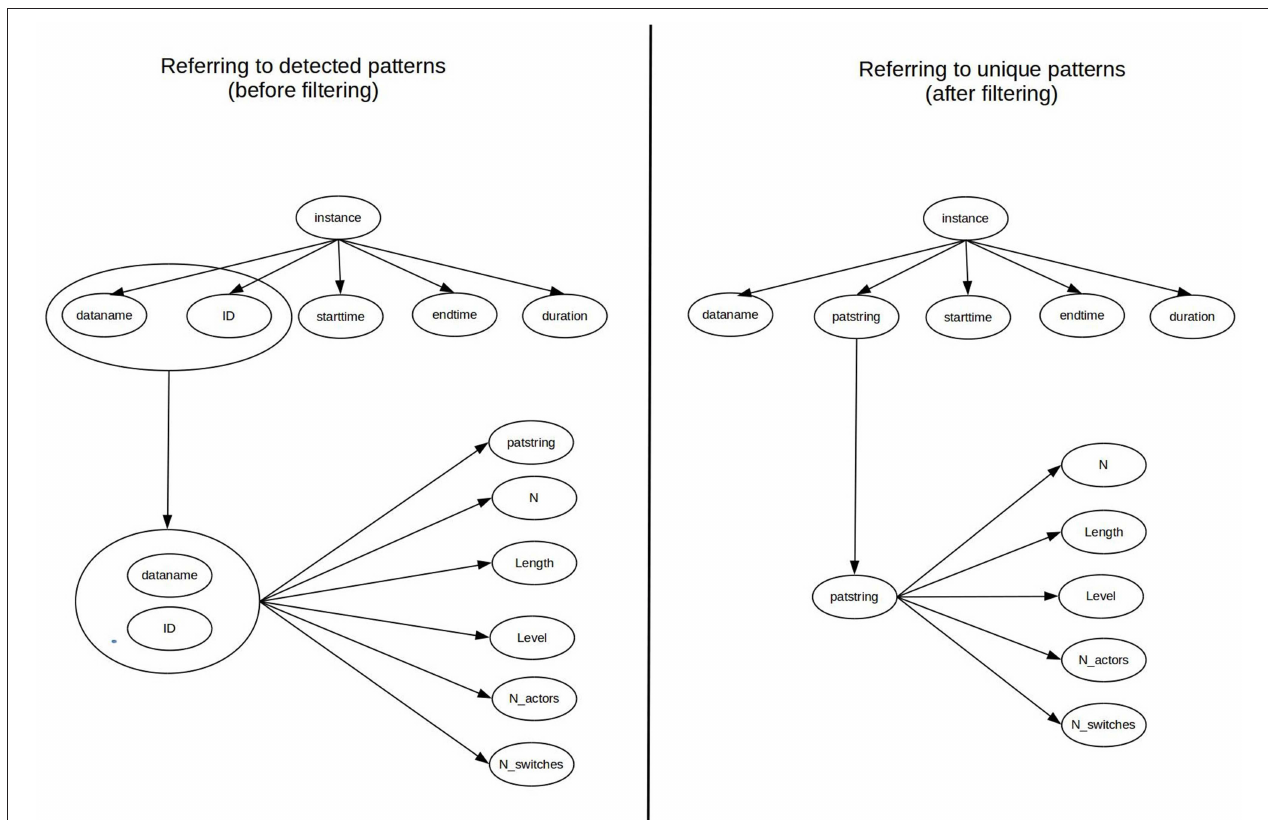
FIGURE 4 | Data dependency graph of the exported data before and after filtering